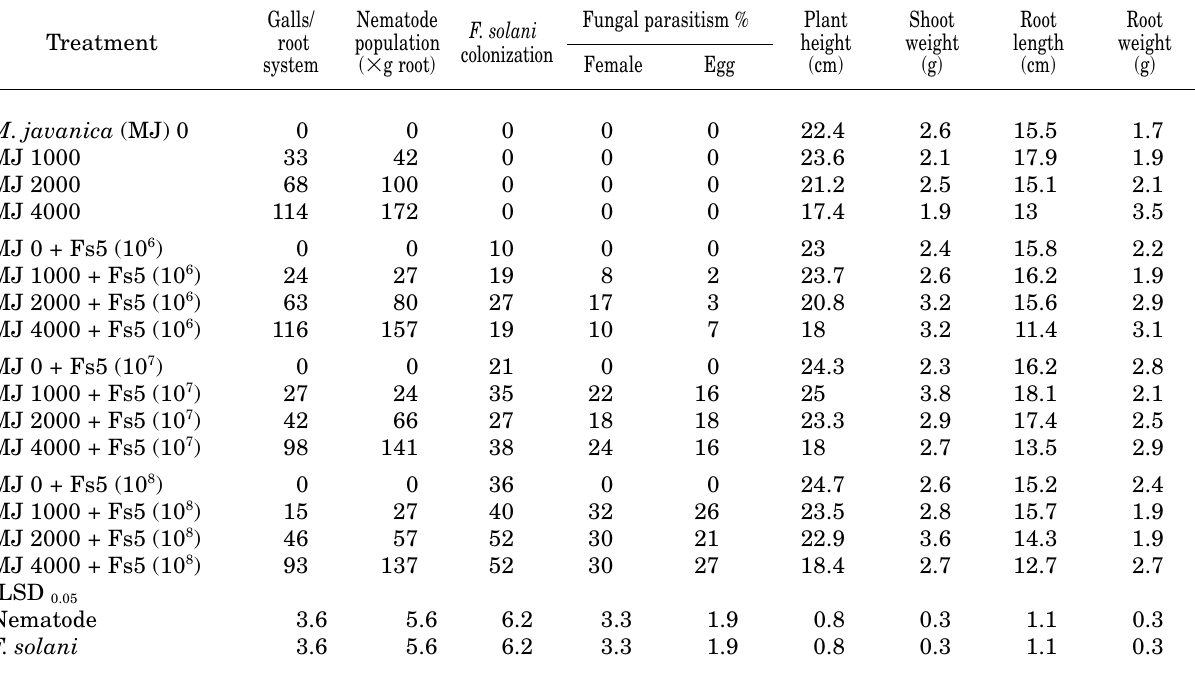
Table 2. Effect of various inoculum levels of Fusarium solani strain Fs5 on various population densities of Meloido- gyne javanica on tomato, as shown by development of root-knot infection, M. javanica invasion, root colonization by F. solani , female and egg parasitism of M. javanica by the fungus, and growth of tomato plants.